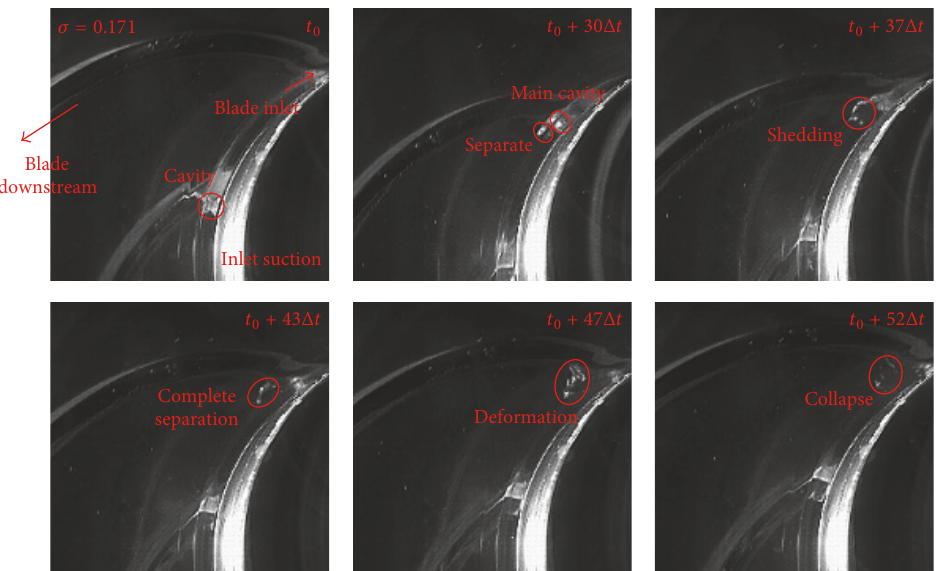
Figure 12: Cavitation developing process at cavitation number 𝜎 = 0.171 .